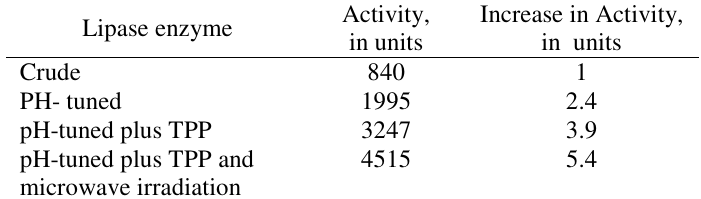
Table 1. Enhancement of lipase activity with pH-tuning, three phase partitioning and microwave